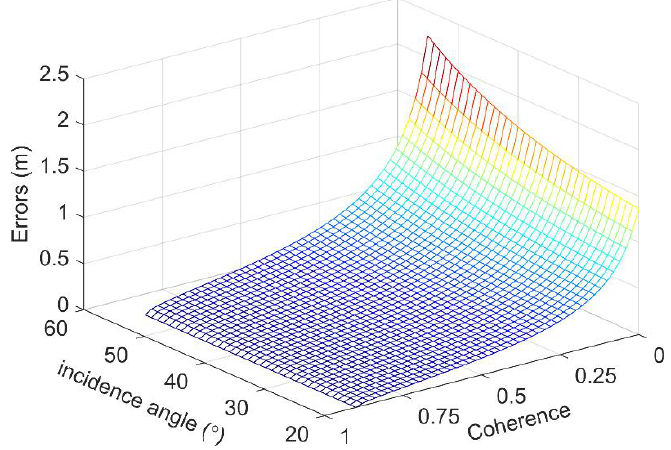
Figure 8. Relationship of the errors of the NOV-estimated subsidence with respect to coherence ( γ = 0.1 ∼ 1.0) and incidence angles of the current LEO SAR systems (i.e., θ = 25 ◦ ∼ 55 ◦